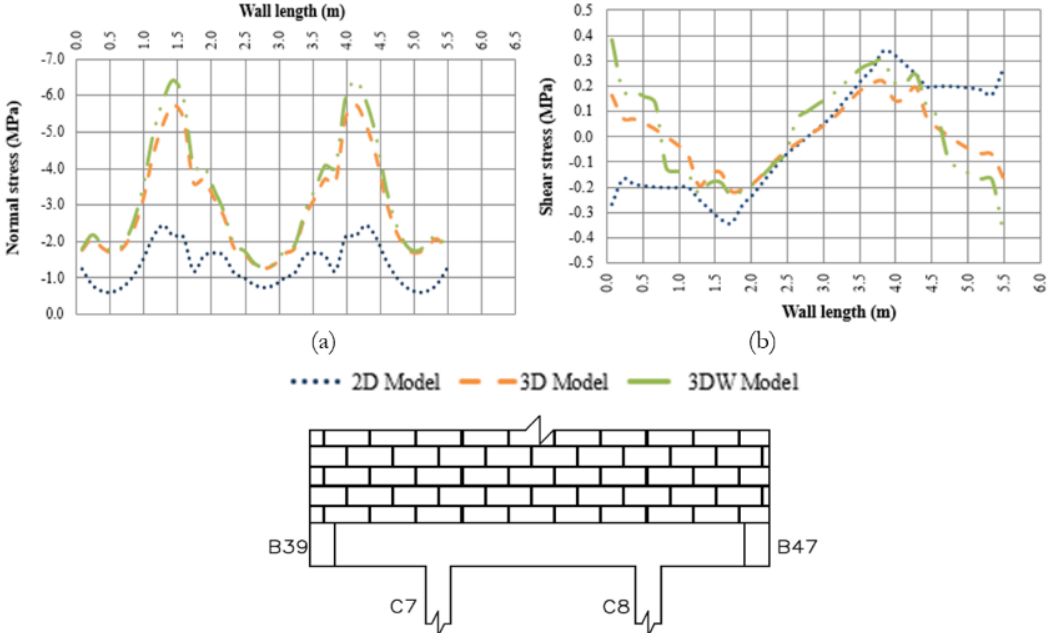
Figure 12. Stress distribution at the bottom of Wall 3: (a) Normal stress; (b) Shear stress.